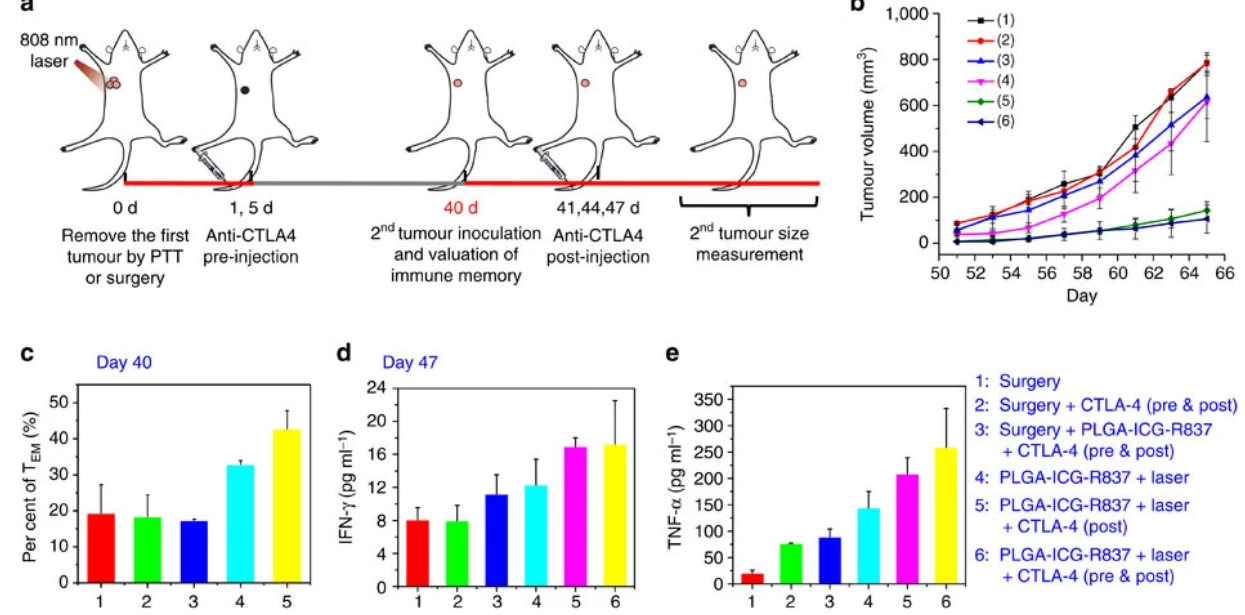
Figure 5. Ability of the immuno-PTT mediated by ICG- and R837-loaded nanoparticles combined with CTLA-4 blockade to prevent tumor recurrence. ( a ) Schematic representation of the treatment procedure; ( b ) Volume of the re-inoculated tumors; ( c ) T EM cells levels in the spleen prior to cancer cell re-inoculation; ( d ) IFN- γ and ( e ) TNF- α levels in the serum of mice seven days after tumor re-inoculation. Reprinted with permission from [38]. Copyright 2016 Nature. Surgery: primary tumor removed by surgery; PLGA-ICG-R837: R837- and ICG-loaded PLGA nanoparticles/PLGA nanoparticles-loaded with ICG and R837; CLTA-4: anti-CTLA-4 Ab administration Laser: NIR light irradiation.